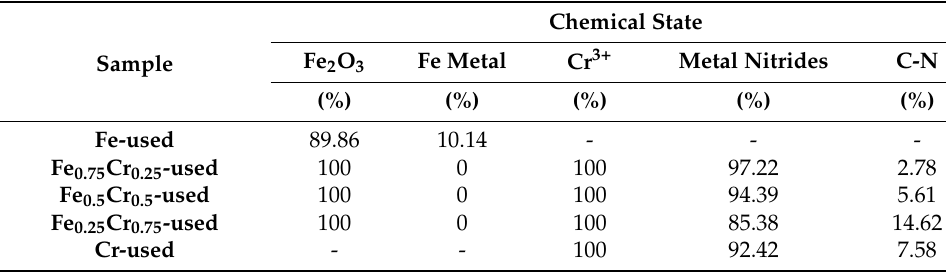
Figure 9. XPS spectra of used FeCrOx catalysts: ( a ) Fe 2p, ( b ) Cr 2p, and ( c ) N 1s. Table 6. XPS fitting results for used FeCrOx catalysts.